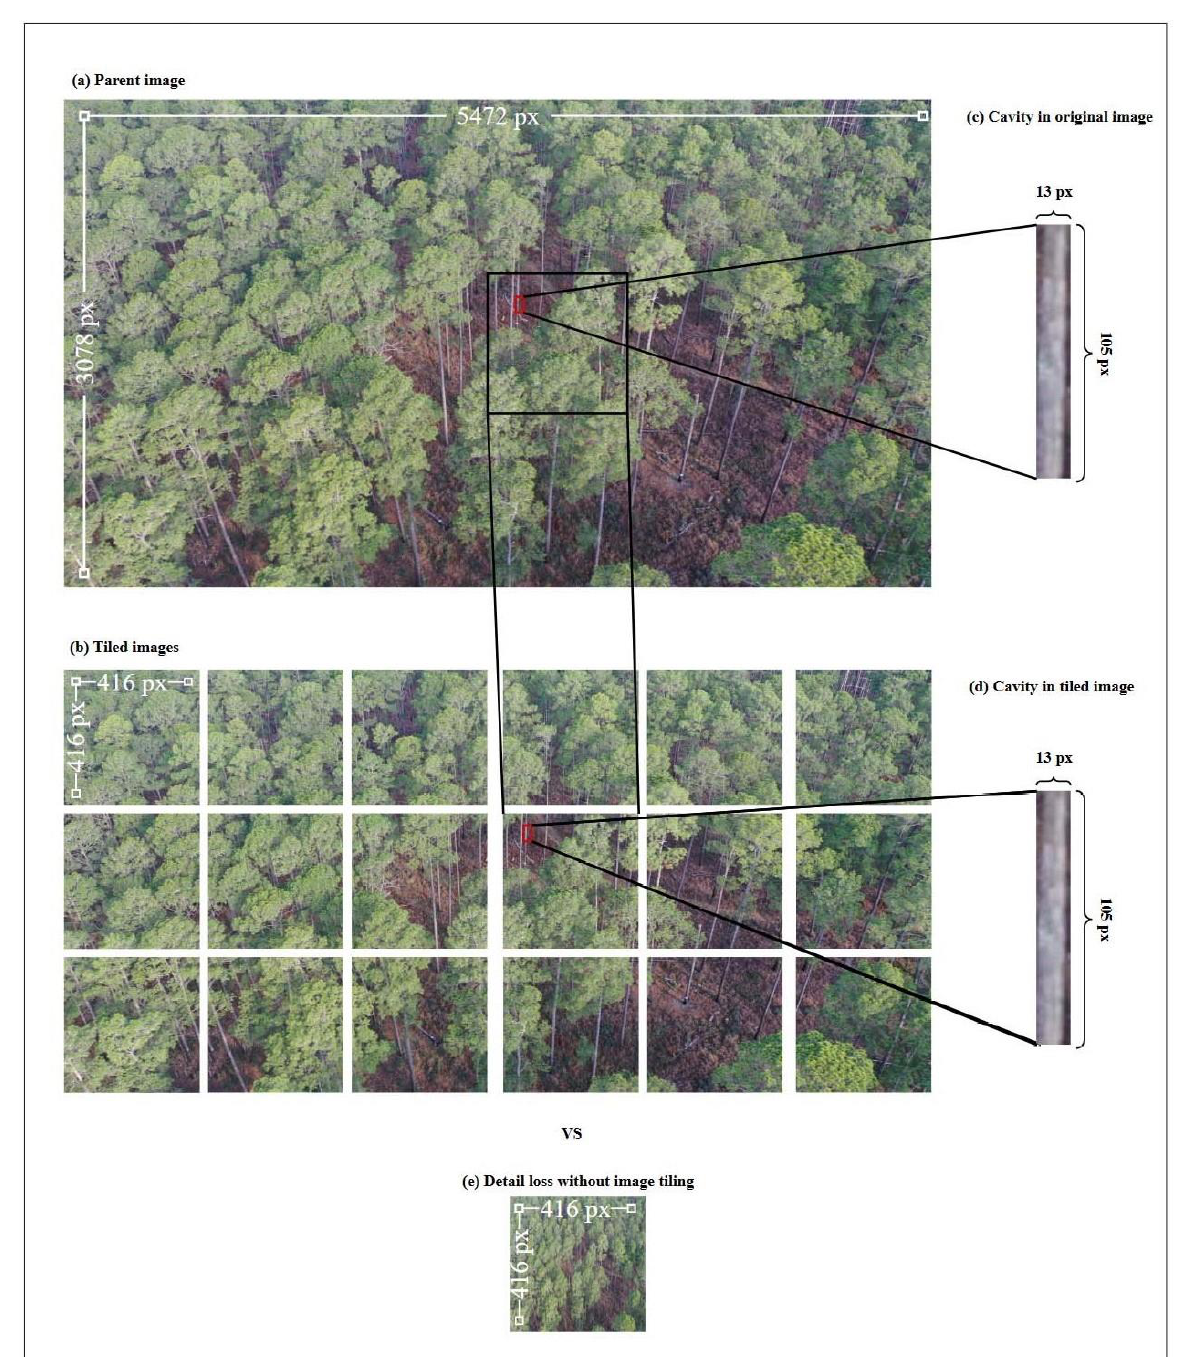
Figure 5. Example of the total pixel dimensions (3078 × 5472) of ( a ) an original aerial image, ( b ) the pixel dimensions (105 × 13) of RCW cavity image, ( c ) image object loss from normal compression, and ( d ) image object with tiling. Because our targeted image objects (i.e., cavity trees) were, on average, 1/3630, the size of an overall original image, cavity trees would be lost to image compression during model training. To address loss from compression, we used tiling, which partitions the original image into tiles of the model’s input size. This approach enabled preservation of minute details necessary for effective small-object detection. ( e ) An example of an original image compressed to YOLOv4-tiny input pixel dimensions without tiling. If tiling was not used, our image objects would be completely lost from image compression and prior to model training.